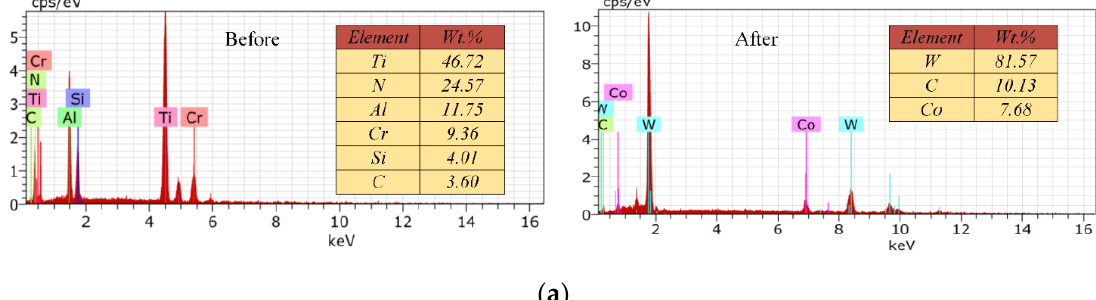
Figure 17. Variations of cutting-edge radii with milling distance.